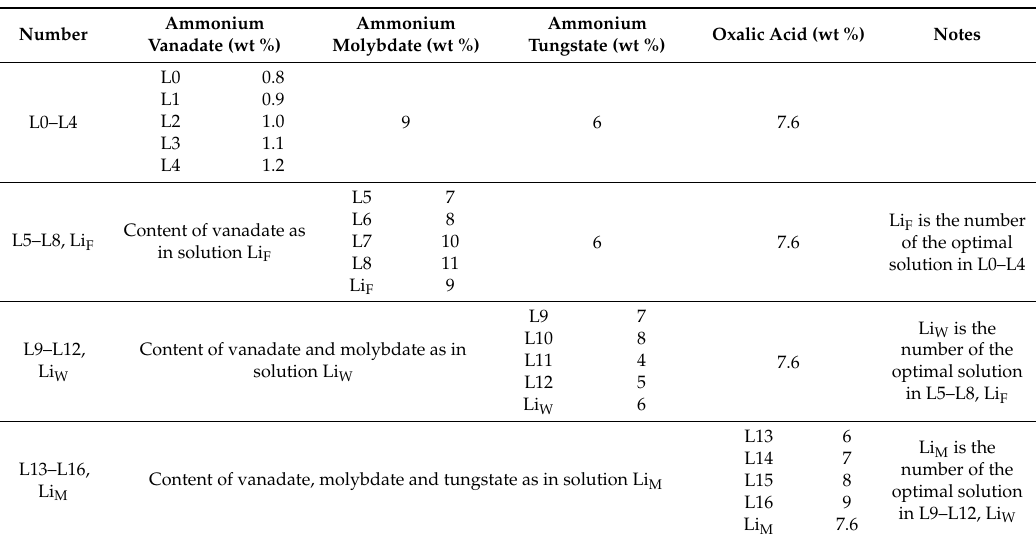
Table 2. Mass percentage of activating